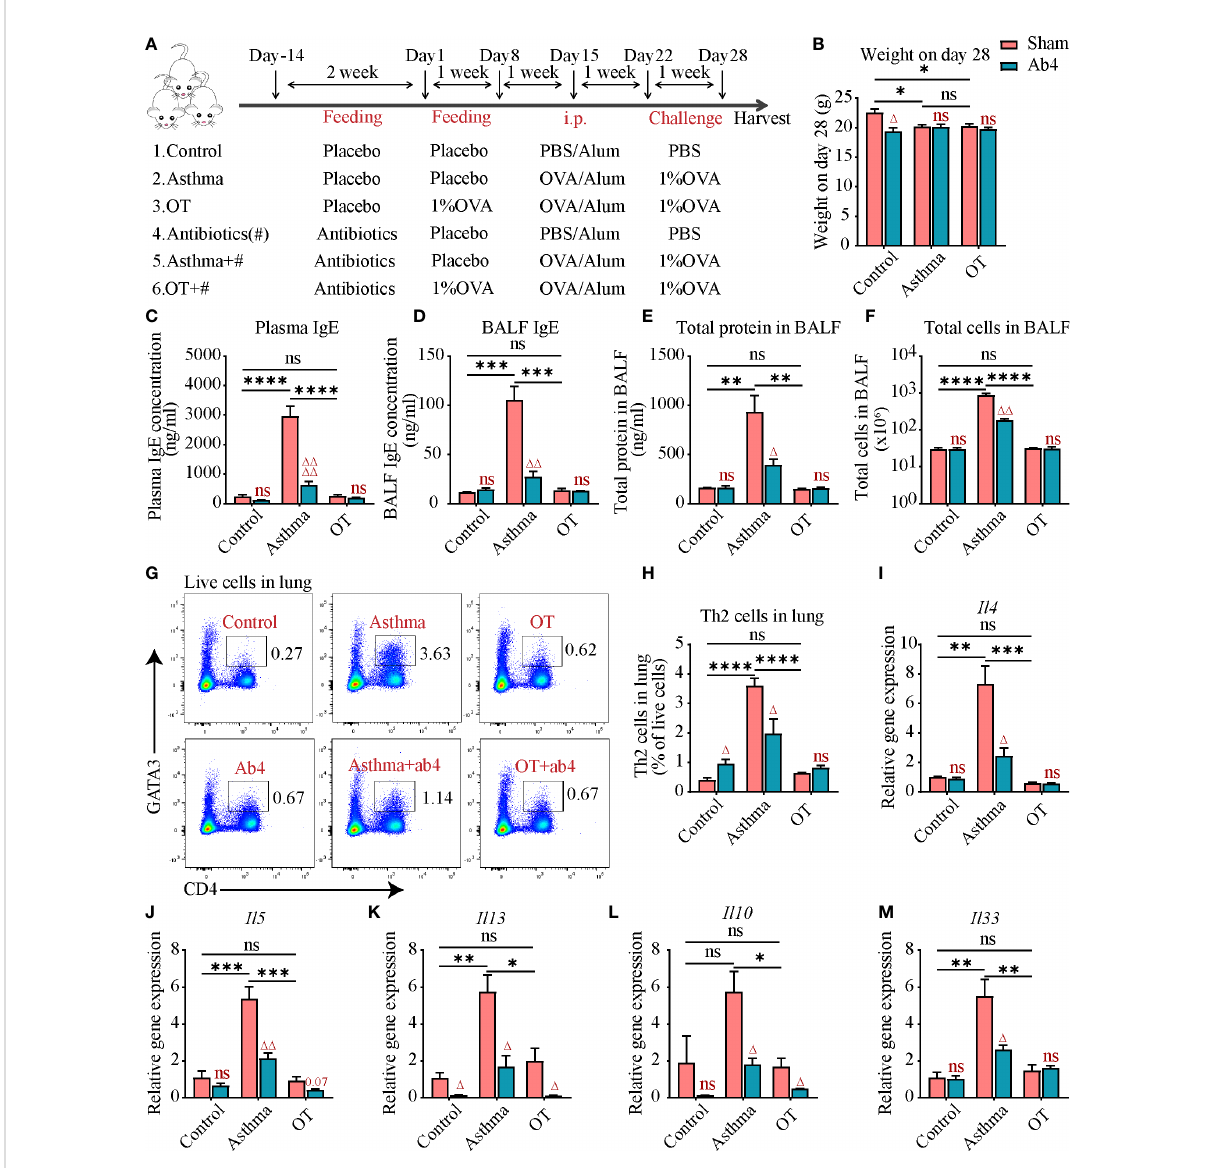
FIGURE 1 Antibiotic treatment alleviates allergic asthma. (A) Experimental protocol for establishing asthma and OT mouse models with or without oral antibiotics. # stands for antibiotics. The detailed procedures have been described in the Materials and Methods. (B) Body weight of mice in each group on day 28. (C) Plasma IgE levels assessed by ELISA (data were pooled from 3 independent experiments, N=3-4 in each